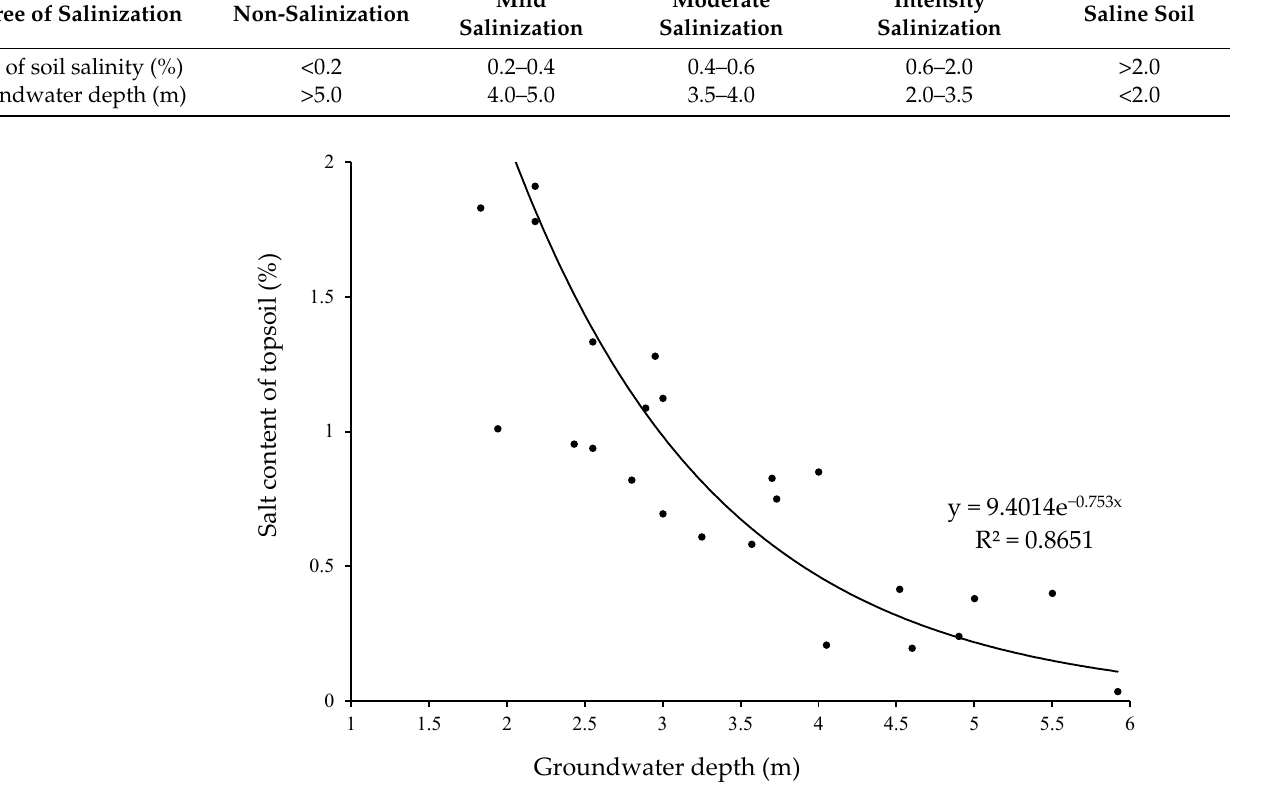
Figure 6. Correlation between salt content of topsoil and groundwater depth.